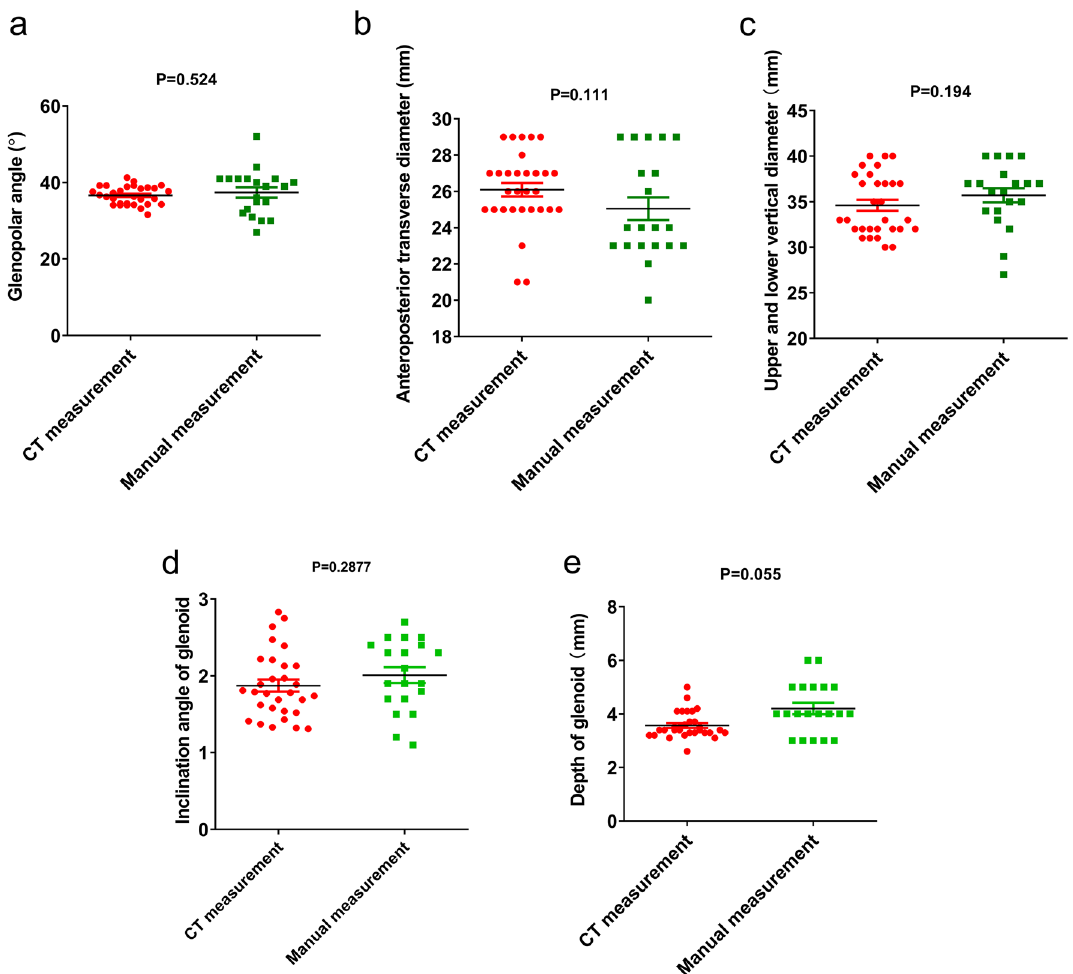
Figure 2. Comparisons of manual and CT measurements of the glenoid. ( a ) Glenopolar angle. ( b ) Anteroposterior transverse diameter of glenoid. ( c ) Upper to lower vertical diameter of glenoid. ( d ) Inclination angle of glenoid. ( e ) Depth of glenoid.